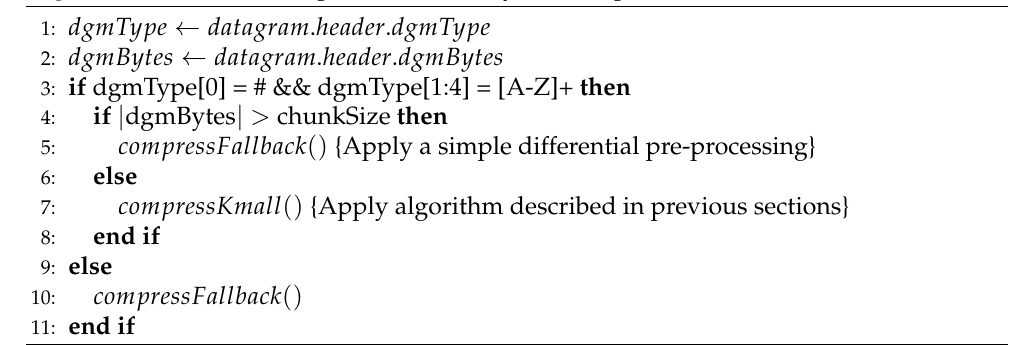
Algorithm 1 KMALL datagrams consistency check algorithm.